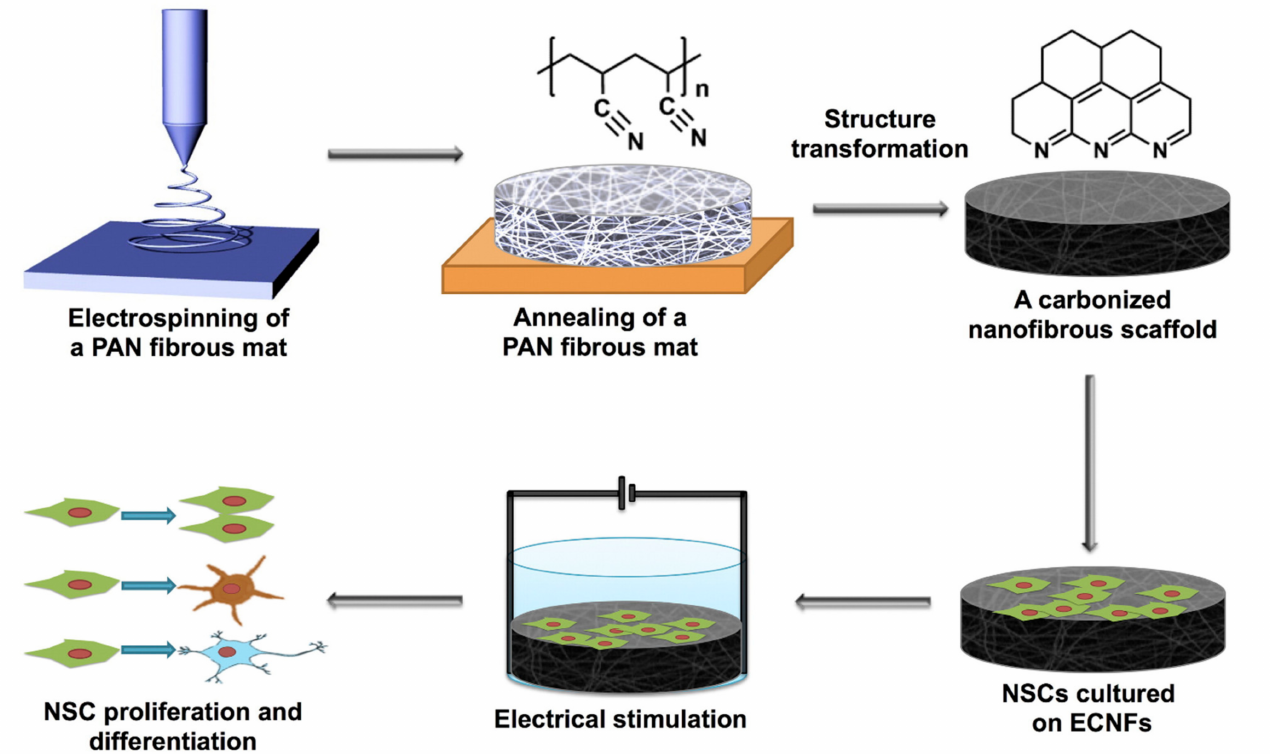
Figure 6. A schematic illustration of ECNF scaffold fabrication and electrical stimulation of NSCs on the scaffold. Adapted with permission from Ref.